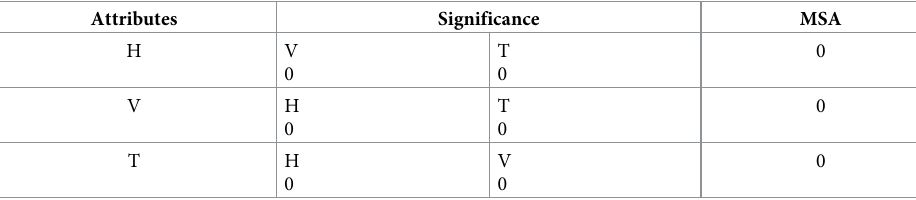
Table 6. Significance degree of attributes from Table